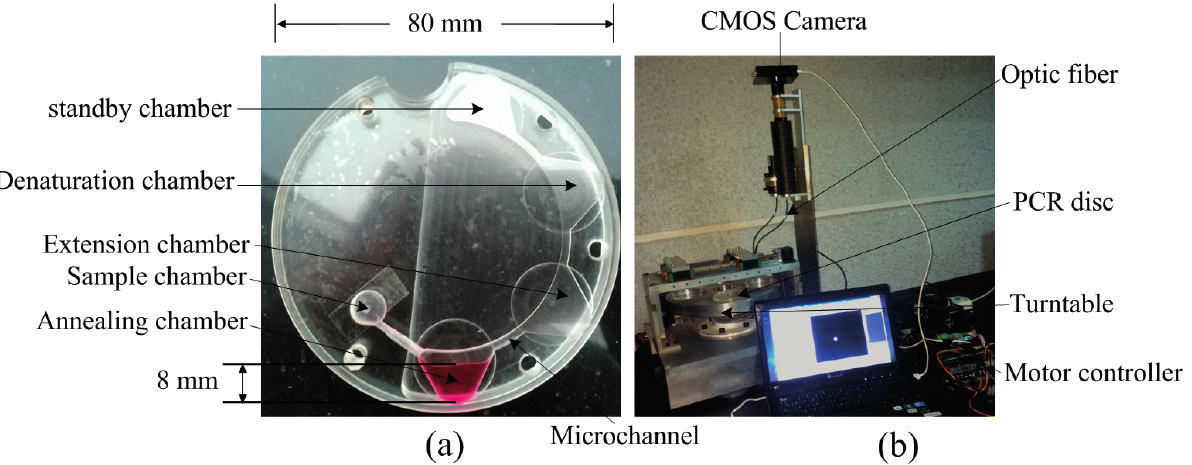
Figure 3. ( a ) Images of an assembled PCR disc; ( b ) The complete system, including turntable, PCR disc, and motor